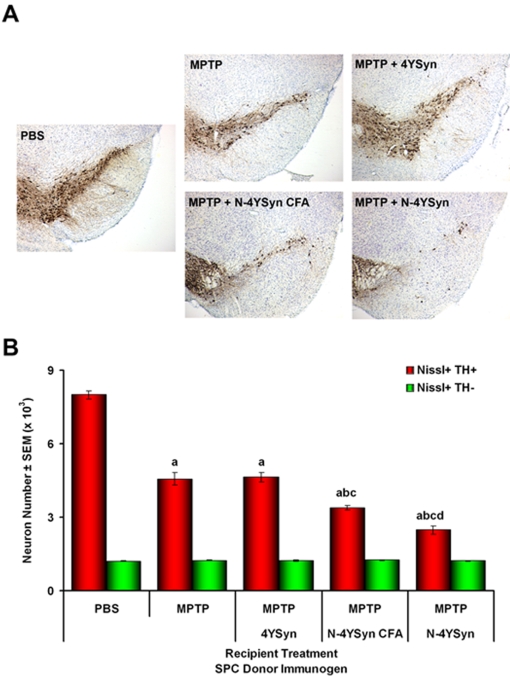
Lymphocytes from N-4YSyn immunization exacerbate nigral dopaminergic neuronal loss in B6 mice.(A) All panels show TH+ neurons in the SN from mice treated with PBS or MPTP alone, MPTP and SPC from 4YSyn immunized donors (MPTP+4YSyn), MPTP and SPC from N-4YSyn immunized donors (MPTP+N-4YSyn) and lastly, MPTP and SPC from N-4YSyn+CFA immunized donors (MPTP+N-4YSyn CFA). (B) Counts of nigral TH+ and TH− neurons on day 7 after MPTP treatment. Experimental groups included mice treated with PBS alone (n = 7), MPTP alone (n = 7), MPTP/4YSyn (n = 7), MPTP/N-4YSyn/CFA (n = 6) and MPTP/N-4YSyn (n = 6). Values are means ± SEM. Analysis by ANOVA with Bonferroni post-hoc tests indicated ap<0.0001 compared to PBS control: bp<0.001 compared to MPTP group; cp<0.001 compared to MPTP/4YSyn group; and dp<0.03 compared to MPTP/4YSynCFA SPC.